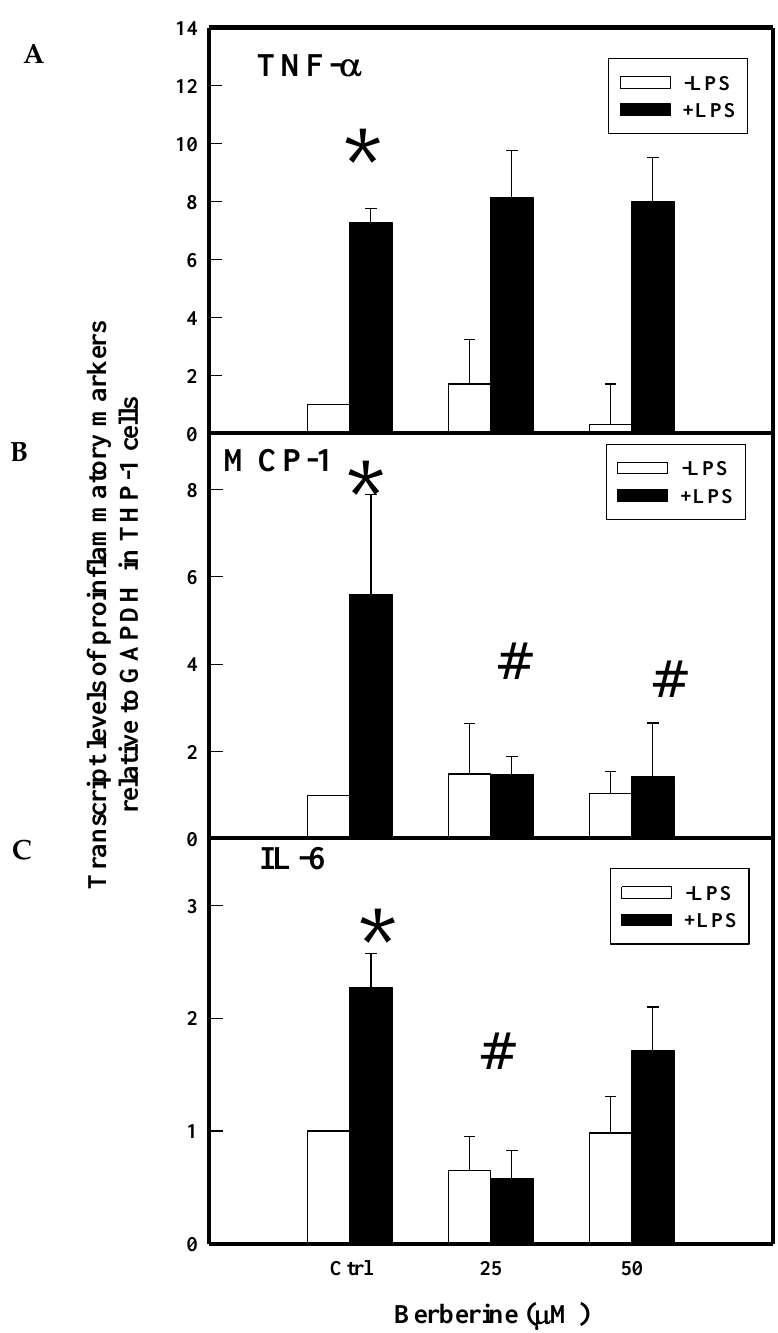
Figure 4. Effect of BBR on LPS-induced proinflammatory gene transcripts. THP-1 cells were pre- treated with BBR and induced with LPS for 3 h. At the end of the treatment, RNA was isolated using TRIzol reagent. Gene transcripts (normalized with GAPDH) of TNF-α ( A ), MCP-1 ( B ), and IL-6 ( C ) were quantified by real time PCR. Ctrl (control) represents cells incubated without berberine. Data represent mean ± SD of three independent experiments and # indicates p < 0.001 compared between treated and untreated with controls, * indicates p < 0.001 between the control groups.